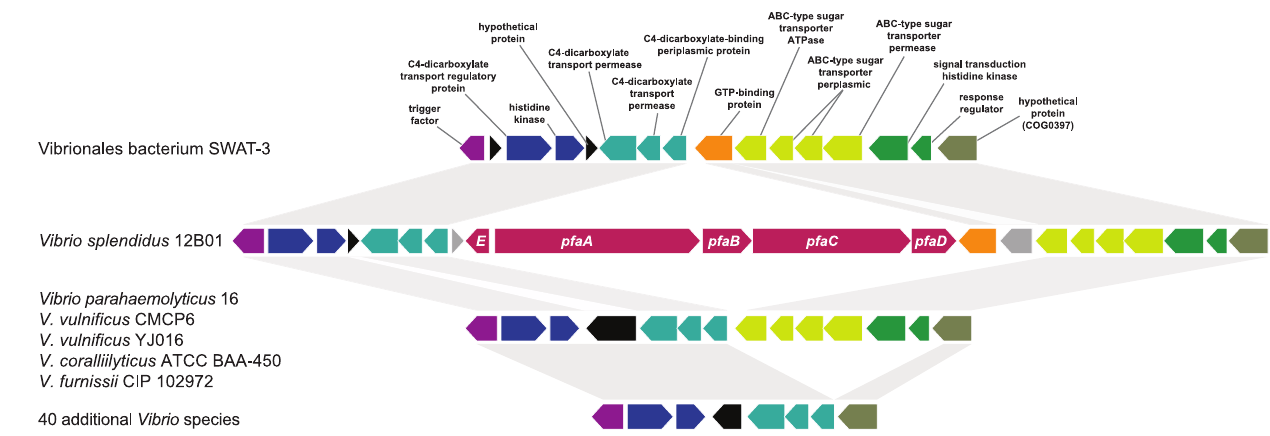
Figure 4. Plot of Vibriosplendidus 12B01 pfa region versus corresponding genomic regions of multiple Vibrio species. Gray tracts indicate regions of homology between genomes. The pfa genes are labeled in the Vibrio splendidus 12B01 genome and are absent in the other Vibrio genomes.